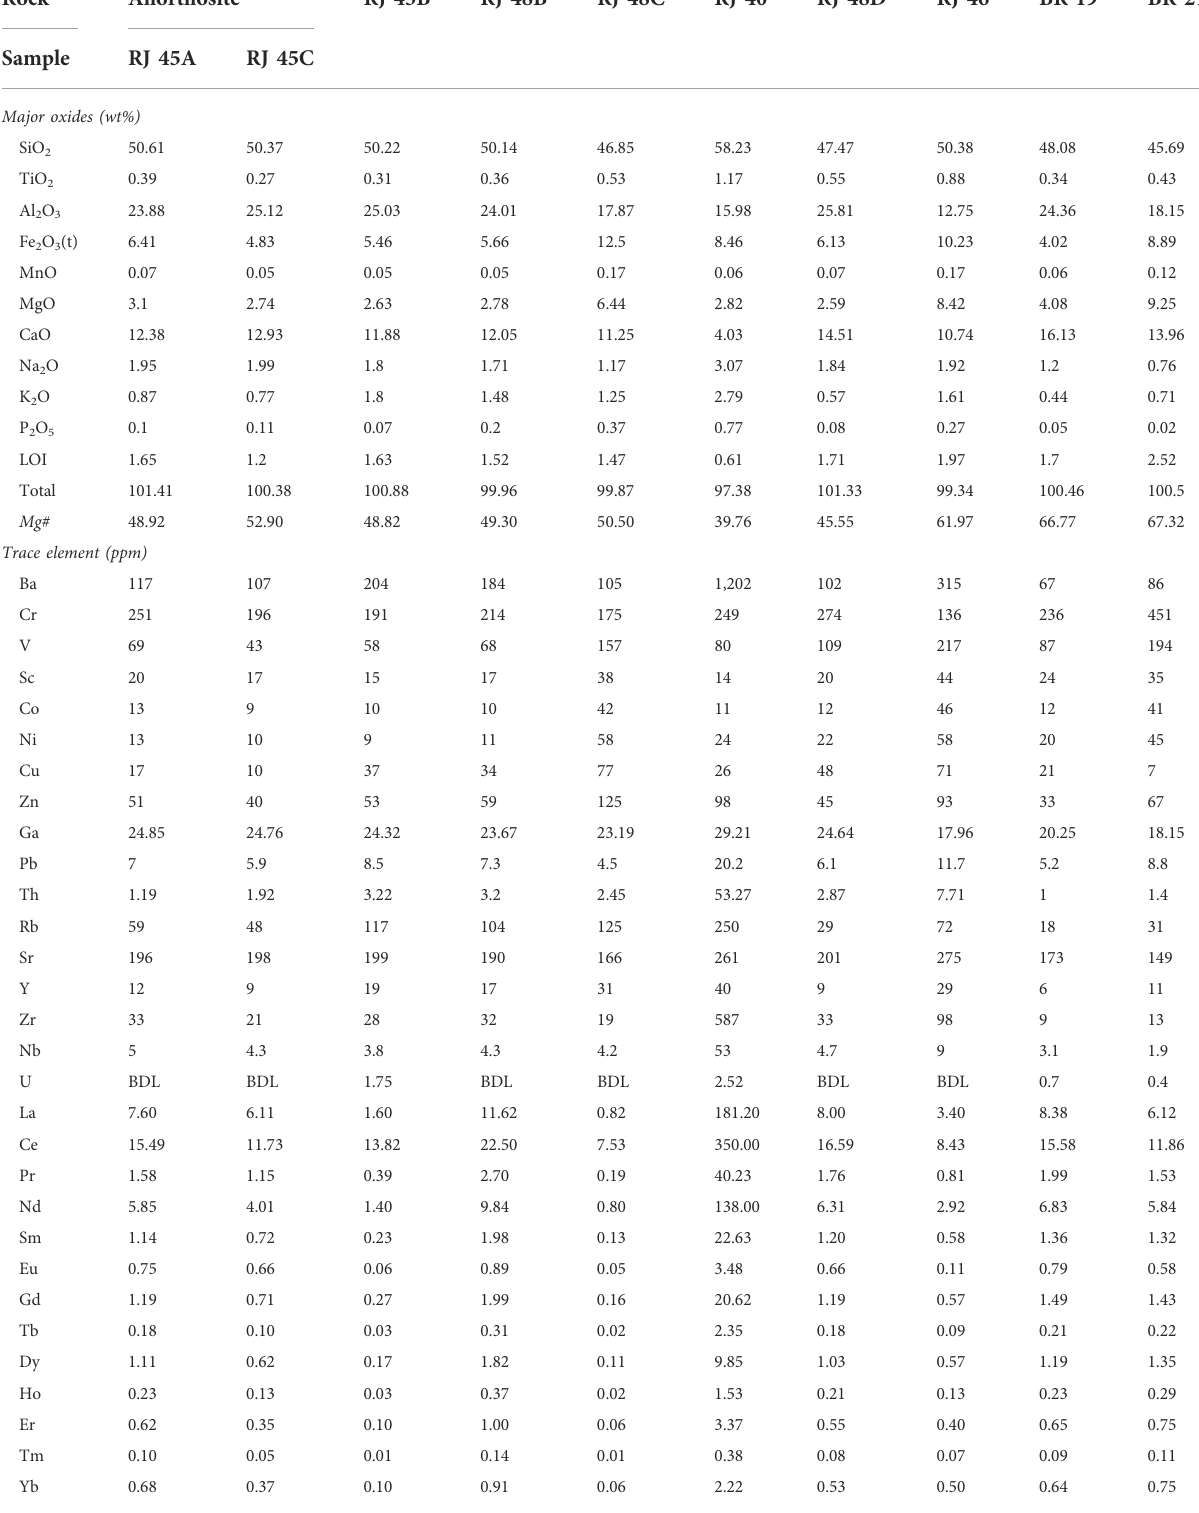
TABLE 1 Whole-rock composition of the studied anorthosite samples from the Chotanagpur Granite Gneiss Complex via X-ray fl uorescence spectrometer and inductively coupled plasma mass spectrometer. Rock Anorthosite